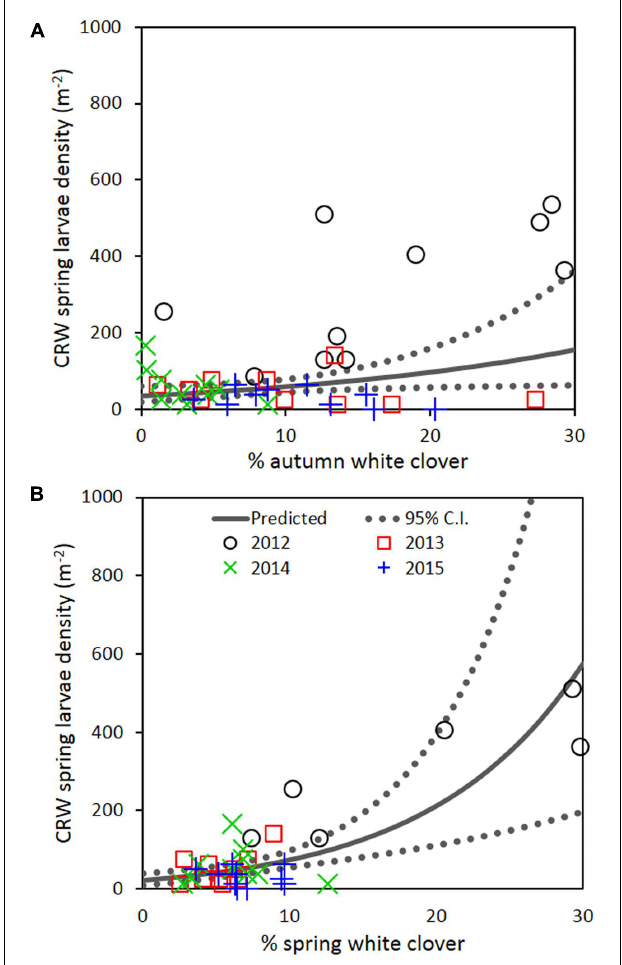
FIGURE 7 | Clover root weevil larval densities measured in spring in relation to % white clover measured in (A) autumn and (B) spring of 2012–2015. The solid line shows predicted density from the repeated measures analysis, with the dotted lines representing 95% confidence intervals of the